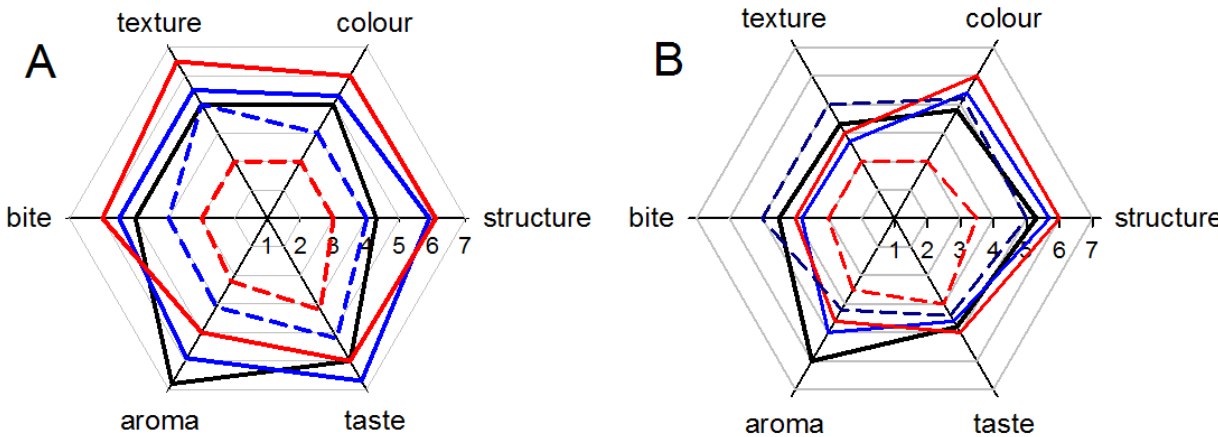
Figure 4. The influence of the inclusion of fermented brewers spent grain on a number of sensory attributes of sourdough breads over time. ( A ) represents the responses on the day of production ( n = 17); ( B ) represents the responses on the third day following production ( n = 15). Solid black lines represent the control sourdough bread with no FBSG; solid blue lines represent the sourdough bread with 5% FBSG; solid red lines represent the sourdough bread with 10% FBSG; dotted blue lines represent the sourdough bread with 15% FBSG; dotted red lines represent the sourdough bread with 20% FBSG.